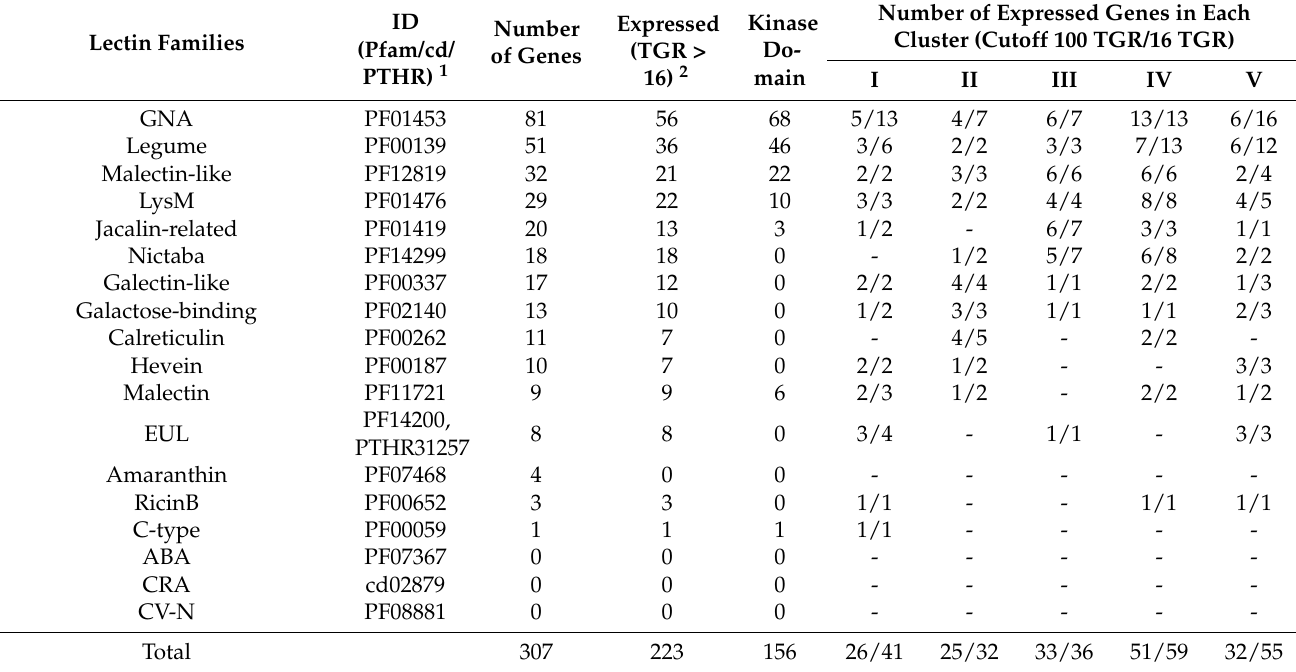
Table 1. Maize lectin families and their expression in the primary